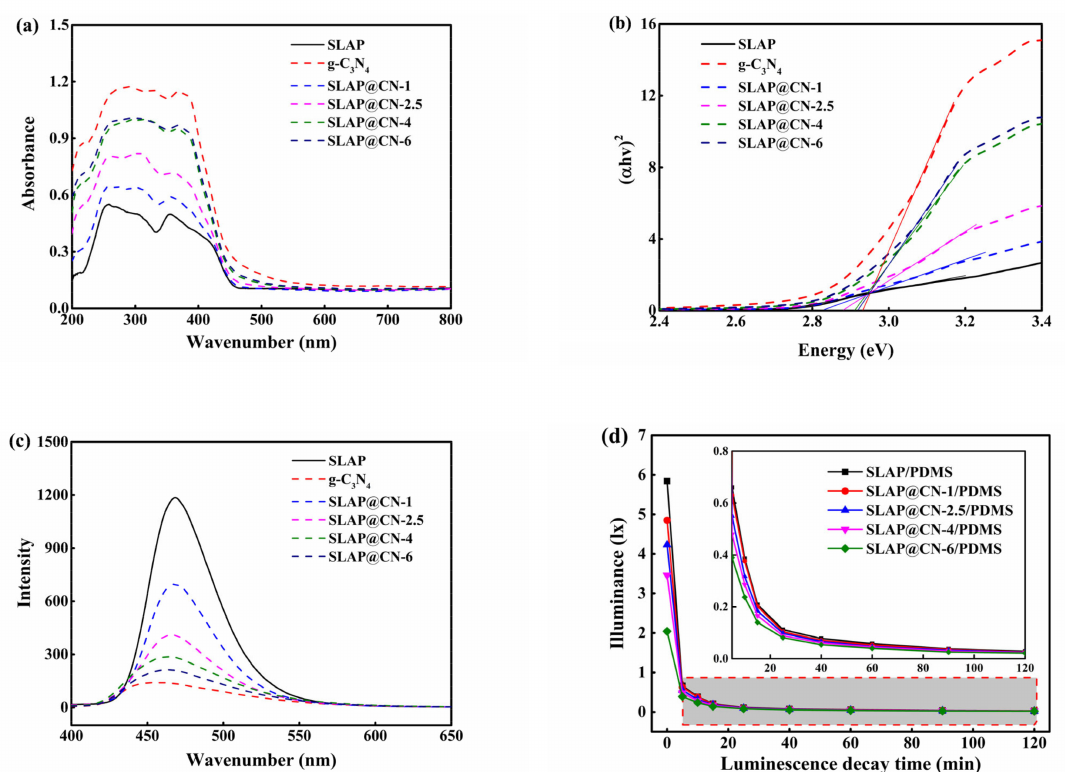
Figure 5. ( a ) UV–Vis spectra of g-C 3 N 4 , SLAP, and SLAP@CN composite powders; ( b ) E g of g-C 3 N 4 , SLAP, and SLAP@CN composite powders; ( c ) PL of g-C 3 N 4 , SLAP, and SLAP@CN composite powders; ( d ) afterglow decay curves of SLAP/PDMS and SLAP@CN/PDMS composite